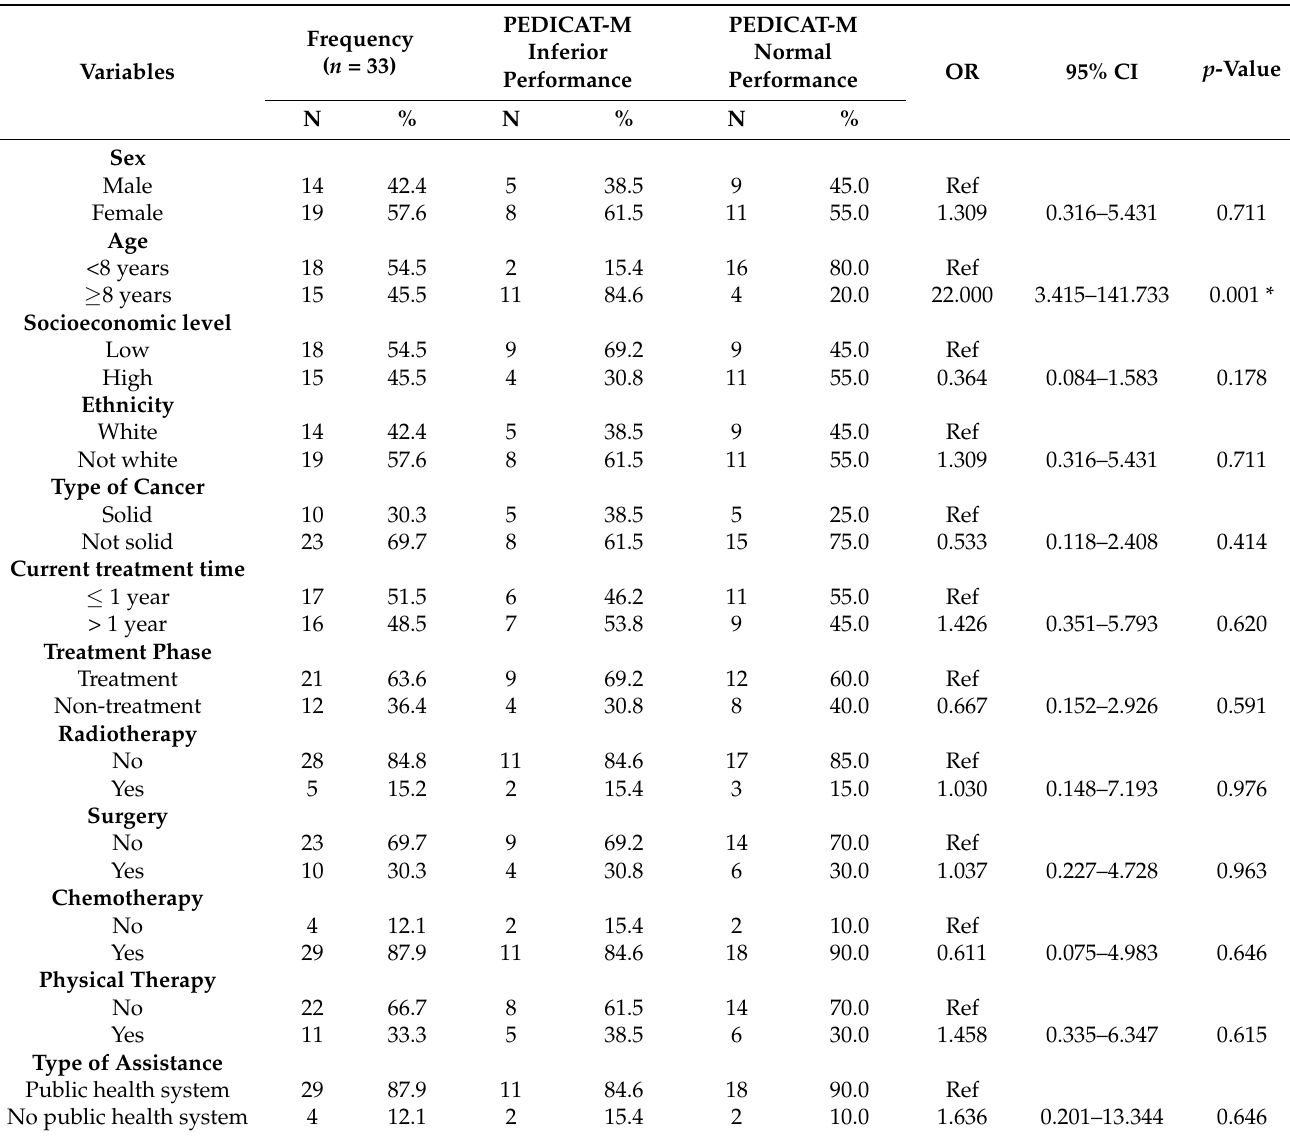
Table 2. Frequency, number of children with inferior and normal performance in PEDICAT-Mobility, odds ratio, 95% confidence interval, and p -value.